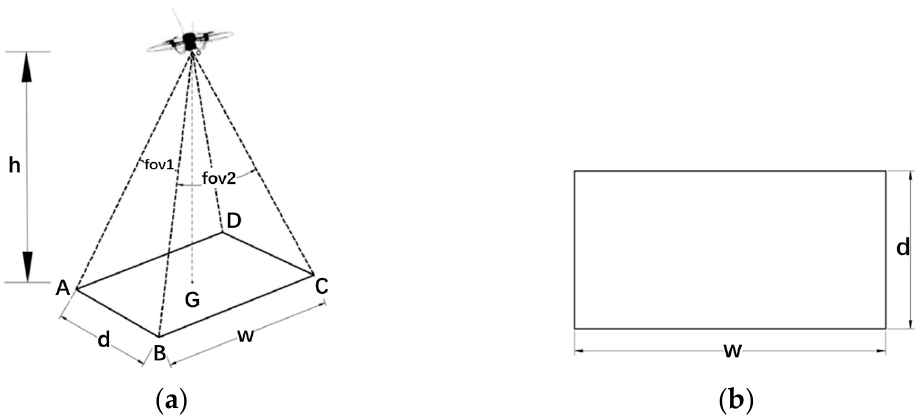
Figure 6. A simplified model of Unmanned Aerial Vehicle (UAV) photography. ( a ) Main view of UAV aerial photography; ( b ) top view of UAV photography.